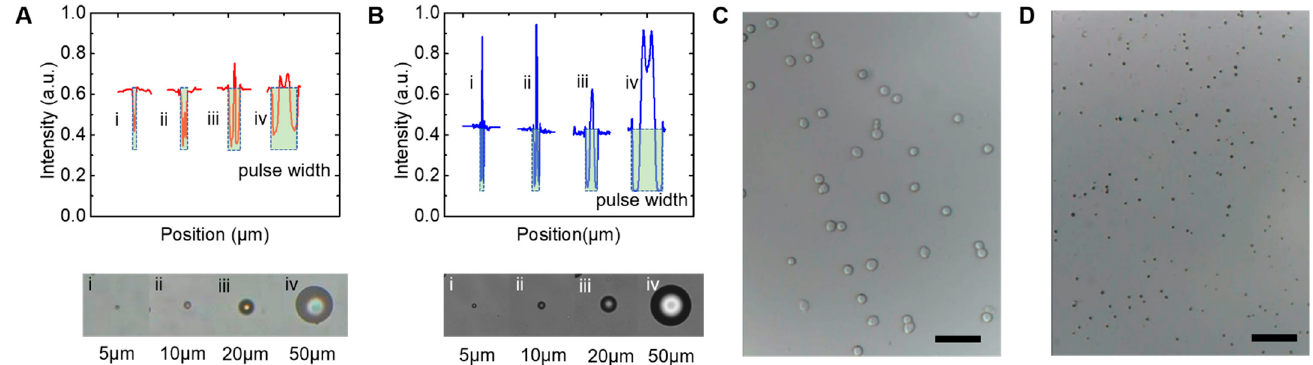
Figure 3. Plots of normalized light intensities as a function of microsphere diameter, for polystyrene particles with diameters of 5 μ m, 10 μ m, 20 μ m, and 50 μ m. ( A ) light intensities of the microscopic images from our device. ( B ) light intensities of the microscopic images from commercial microscope. ( C , D ) Image of human hepatoma cells (HepG2, 25~30 μ m in diameter) and microalgae cells (around 3 μ m in diameter) from our device, respectively. Scale bar are 100 μ m.